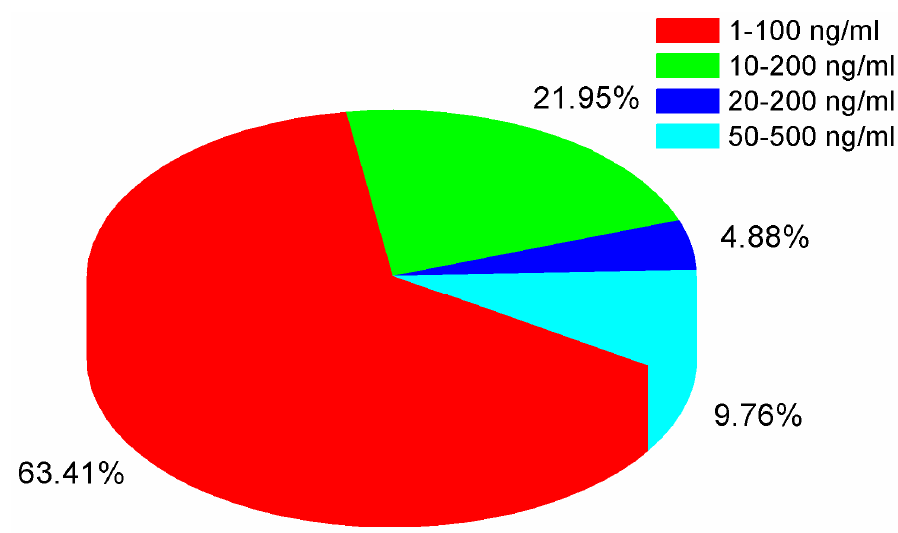
Figure 4. The percentages of different linear range of 82 targeted pesticides.